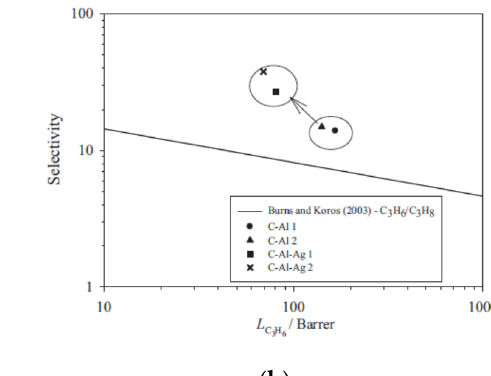
Membrane c/Alumina (wt.%)